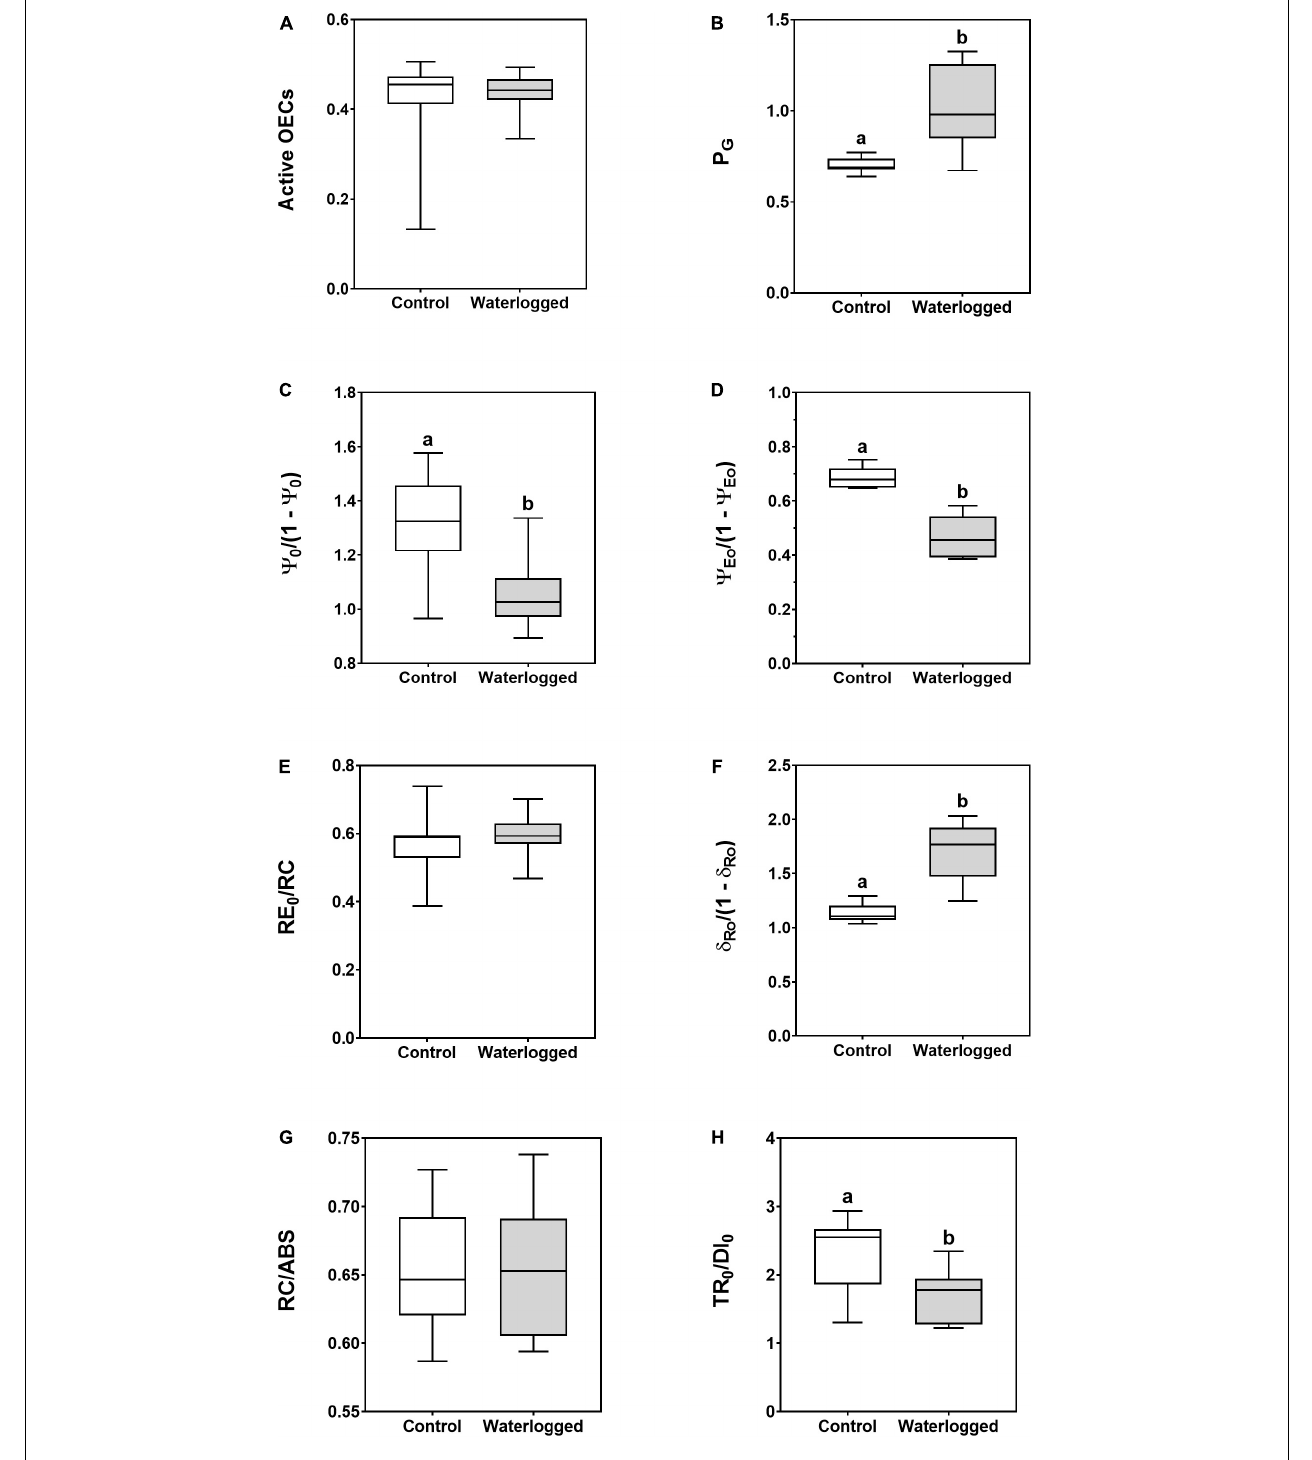
FIGURE 5 | Boxplots of the photosystems I (PS I) and II (PS II) photochemical traits. (A) Active oxygen-evolving complexes (OECs); (B) grouping probability between the two PS II units (PG); (C) the contribution of the dark reactions from quinone A to plastoquinone [ ψ 0 /(1 - ψ 0 )]; (D) the equilibrium constant for the redox reactions between PS II and PS I [ ψ E0 /(1 - ψ E0 )]; (E) electron transport from PQH 2 to the reduction of PS I end electron acceptors (RE 0 /RC); (F) the contribution of PS I reducing its end acceptors [ δ R0 /(1- δ R0 )]; (G) reaction center II density within the antenna chlorophyll bed of PS II (RC/ABS); (H) contribution or partial performance due to the light reactions for primary photochemistry (TR 0 /DI 0 ), in leaves of control plants (white boxes) and waterlogged plants (gray boxes) of Spartina patens after 30 days ( n = 10, different letters indicate significant differences at p < 0.05).